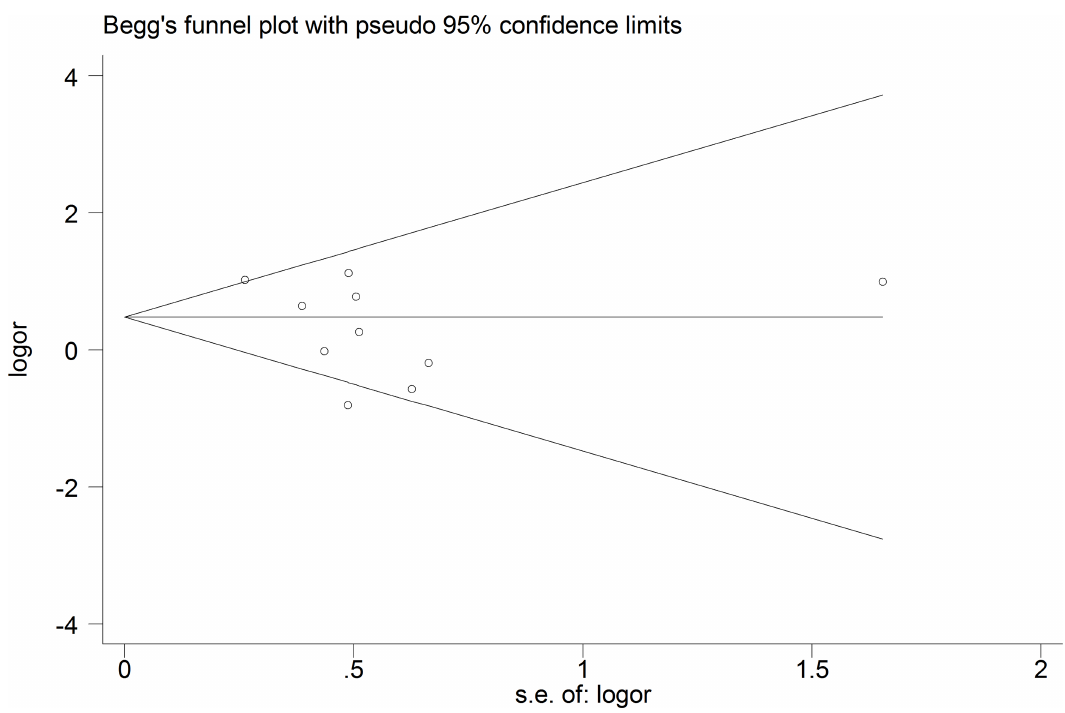
Fig 2. Funnel plot of the prevalenceof “any CSP” in the FEP patients. patients: p = 0.80; sex ratio in the healthy controls: p = 0.68; mean age of the FEP patients: p =